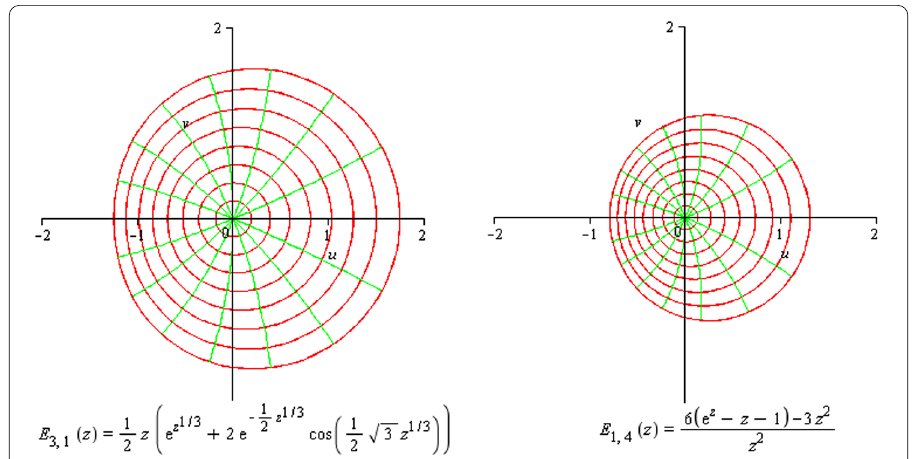
Figure 1 The mapping of U by the indicated